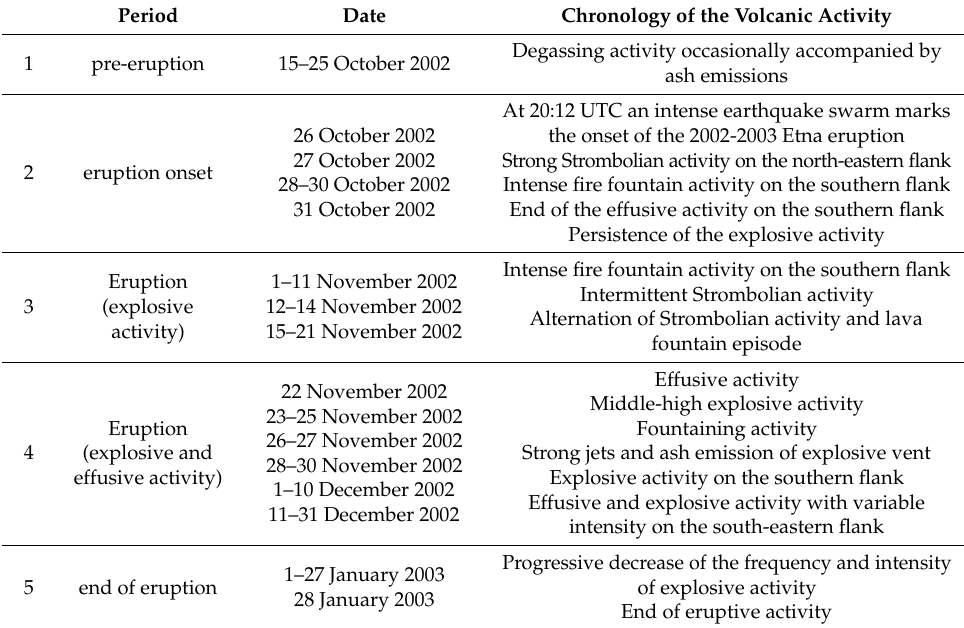
Table 1. Chronology of the volcanic activity during the 2002–2003 Mt. Etna eruption (modified from previous studies [47,50]). Numbers 1 to 5 are the sub-periods of different volcanic activity compared to the increases in background seismic signal amplitudes shown in Figures 2a and 3a.